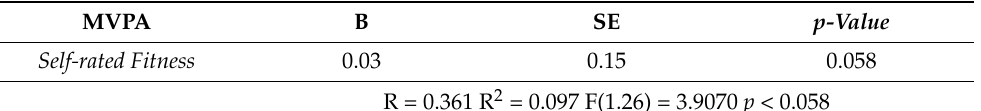
Table 3. Summary of dependent variable MVPA in adolescents, identified on hierarchical regression